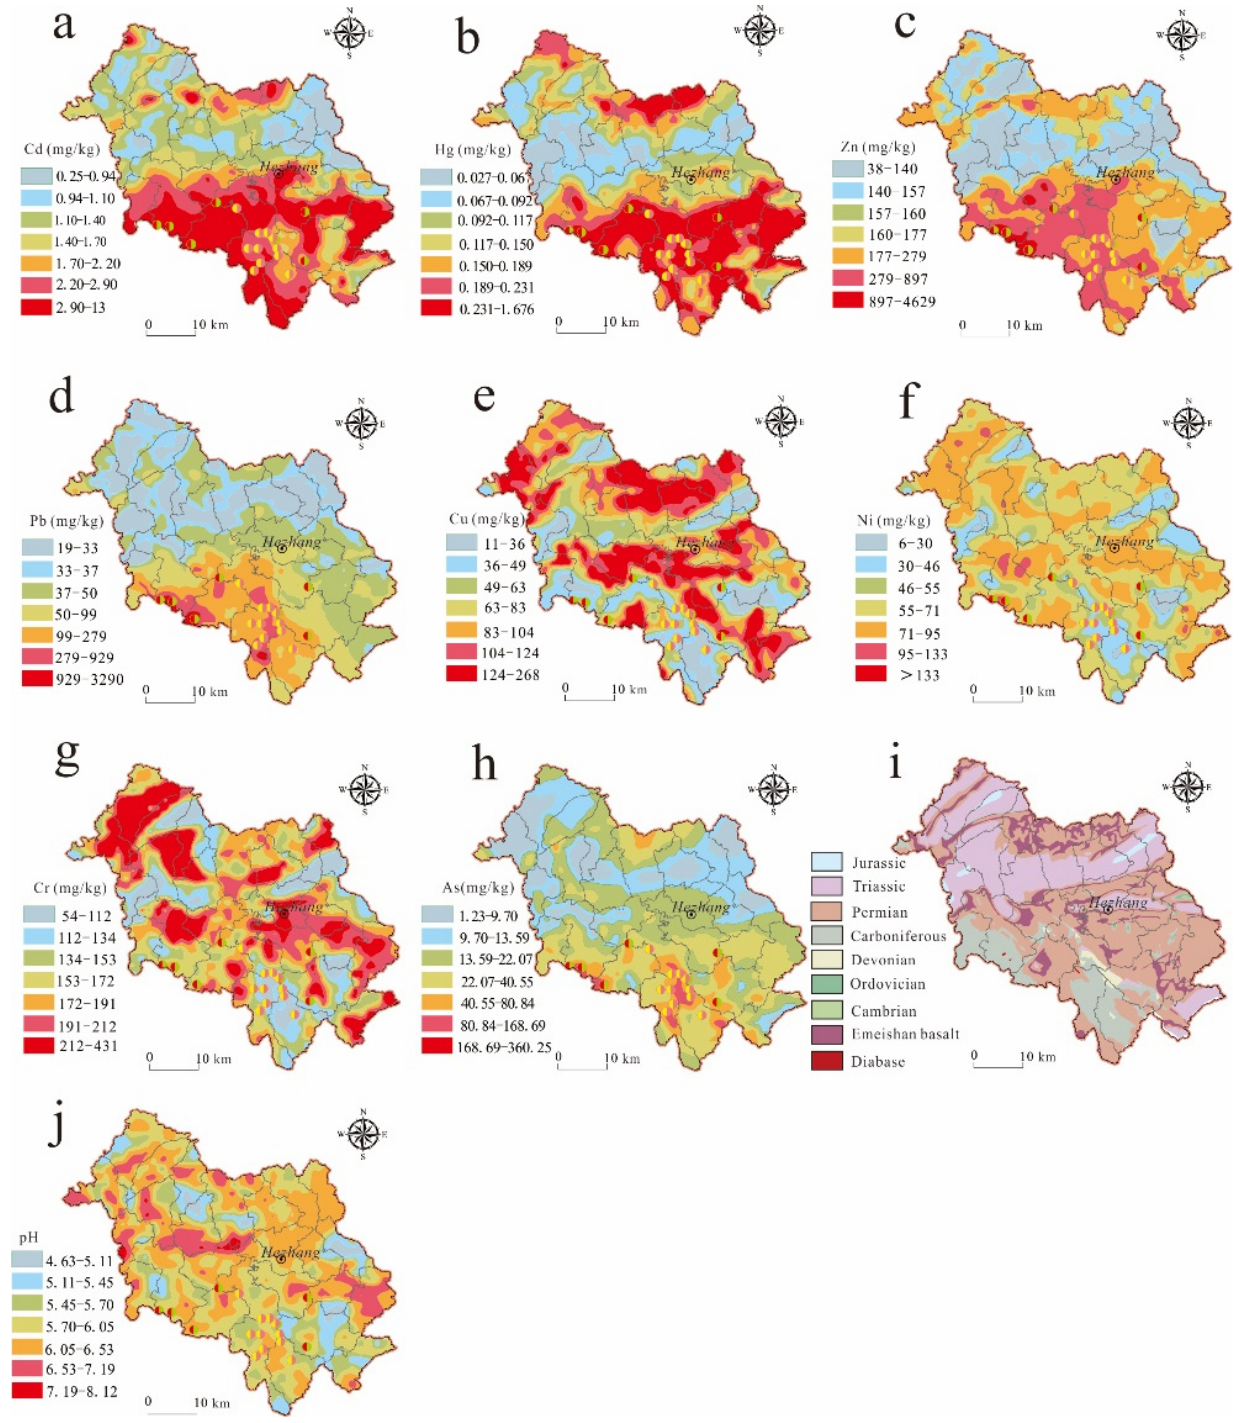
Figure 3. Spatial distribution of ( a ) Cd, ( b ) Hg, ( c ) Zn, ( d ) Pb, ( e ) Cu, ( f ) Ni, ( g ) Cr, ( h ) As, ( j ) pH, and ( i ) geological map of study area. Note: in study area, Late Permian Emeishan formation is dominated with greyish-green dense, amygdaloidal basalt, and other formations are mainly com- posed of limestone and dolomite.